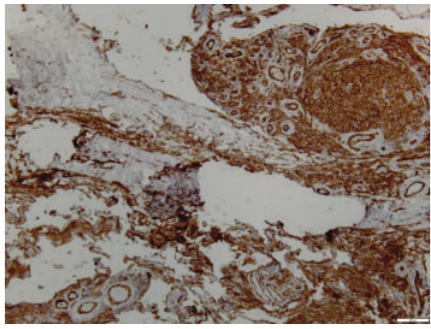
Figure 2: Low power view showing extensive spindle cell prolifera- tion involving dermis, subcutis, and deeper fibroadipose tissue.